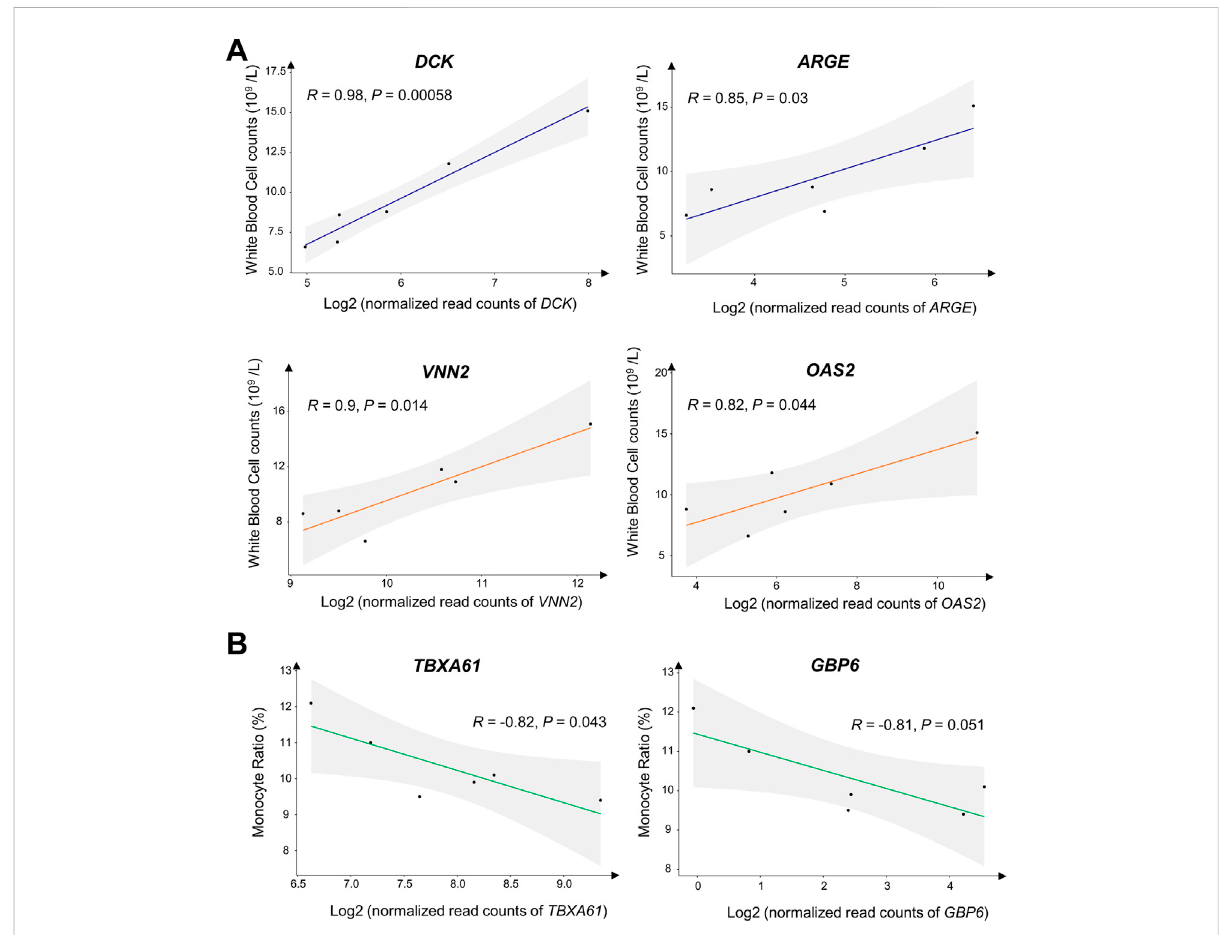
FIGURE 4 Linear analysis of normalized read counts for several differentially expressed genes (DEGs). and routine blood test parameters. (A) DEGs are signi fi cantly associated with White Blood Cell (WBC) count (10 9 /L). (B) DEGs are signi fi cantly associated with Monocyte Ratio (MONO %).